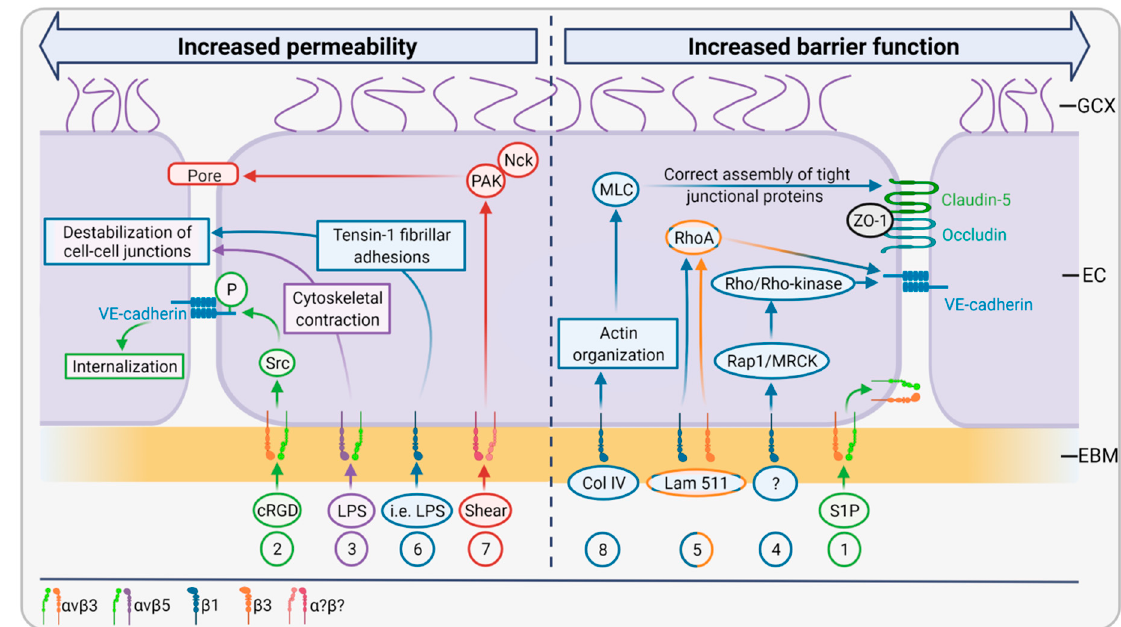
Figure 4. The functional relationship of integrin-mediated cell-matrix and cell-cell interactions. The interactions between the endothelial basement membrane and endothelial cells through different integrins determine the permeability of the endothelial cell monolayer. Here, eight pathways are described; one half are leading to increased permeability and one half to increased barrier function. Integrin α v β 3 can lead to both pathways depending on the stimulus. Whereas sphingosine-1-phosphate (S1P) induces integrin translocation to sites of cell–cell contacts and increases barrier function ( 1 ), cyclic arginine-glycine-aspartate (cRGD) activates Src kinase, which phosphorylates VE-cadherin resulting in its internalization and increased permeability ( 2 ). Integrin α v β 5 is activated by lipopolysaccharide (LPS), which induces cytoskeletal contractions leading to destabilized cell–cell junctions and thus to increased permeability ( 3 ). The integrin subunit β 1 can induce both increased permeability and barrier function. Genetic deletion studies have shown that β 1 activates Rap1/MRCK and Rho/Rho-kinase, which promote VE-cadherin transport to cell–cell contacts and increase barrier function ( 4 ). Similarly, activation of both β 1 and β 3 stimulates RhoA-induced VE-cadherin localization to cell–cell borders ( 5 ). In contrast, β 1, when stimulated by inflammatory agents such as LPS, can contribute to the generation of tensin-1 building fibrillary adhesions, which induce endothelial contractility and destabilize cell–cell junctions ( 6 ). Pathological shear stress also affects integrin-mediated cell–matrix interactions, whereas the particular subunits remain to be identified. Turbulent shear stress can activate p21-activated kinase (PAK) and its adaptor protein (Nck), resulting in paracellular pore formation and thus increased permeability ( 7 ). Finally, β 1 can also mediate barrier function via tight junctions. Deletion experiments proved that β 1 influences the actin reorganization and phosphorylation of the myosin light chain (MLC), which induces redistribution of the tight junctional proteins claudin-5, occludin, and zonula occludens-1 (ZO-1), resulting in increased barrier function ( 8 ).